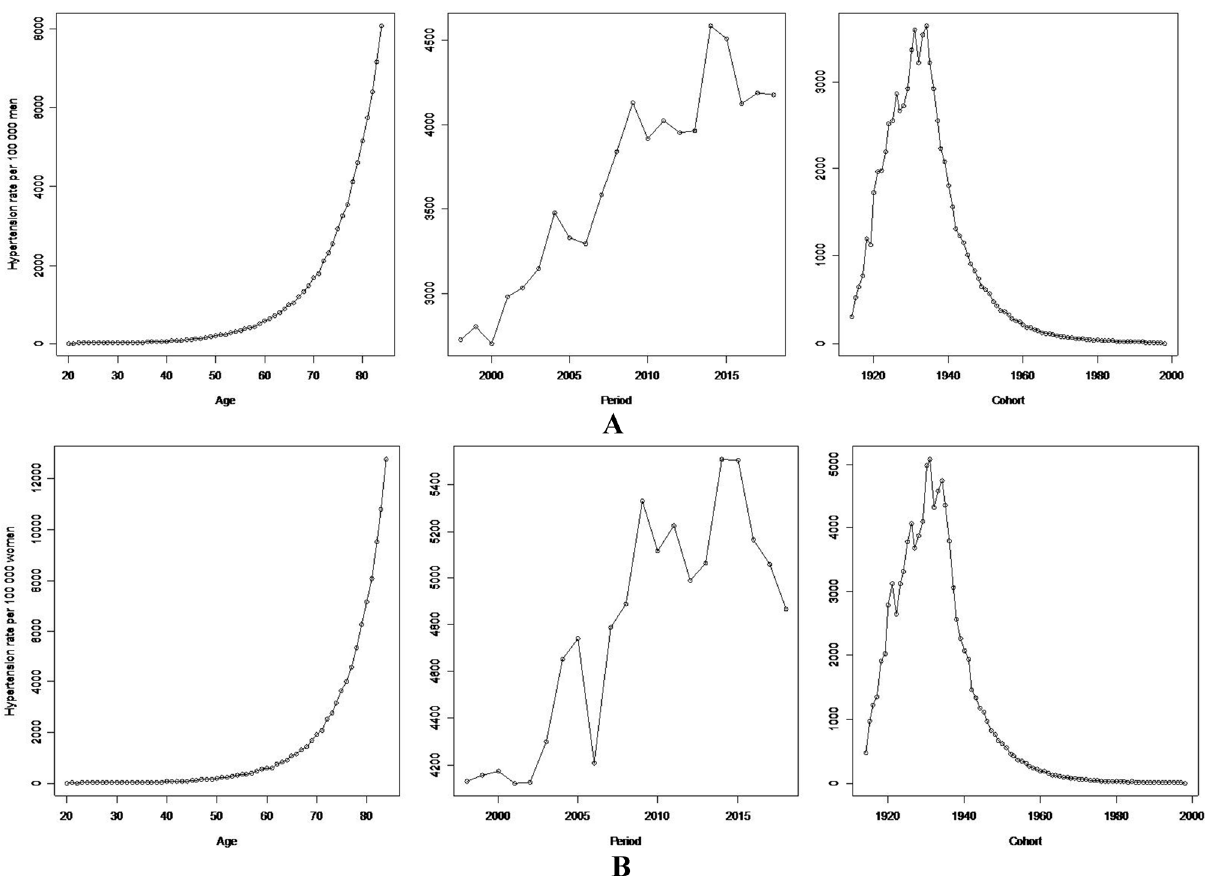
Figure 2. Hypertension mortality rate by age, period and cohort. Mexico, 1998–2018. ( A ) Men. ( B )